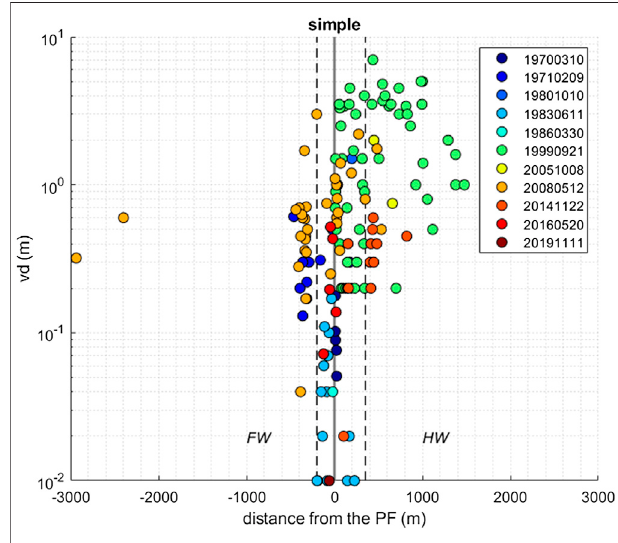
FIGURE 6 | Analysis of the spatial distribution of the vertical displacement, vd, observations of simple DR (ranking 2) by earthquake in respect to the distance from the principal fault on hanging wall (HW) and on footwall (FW) sides. Dashed lines on FW and HW, in 200 and 350 m distance respectively, indicate the zone in which the database contains the largest variability of the values and can be assumed to be the most complete respect to the total DR occurred in